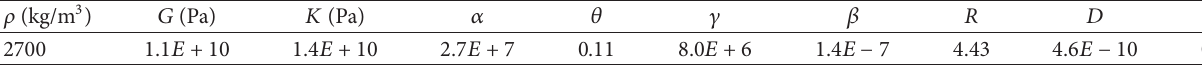
Table 1: Material properties of concrete.